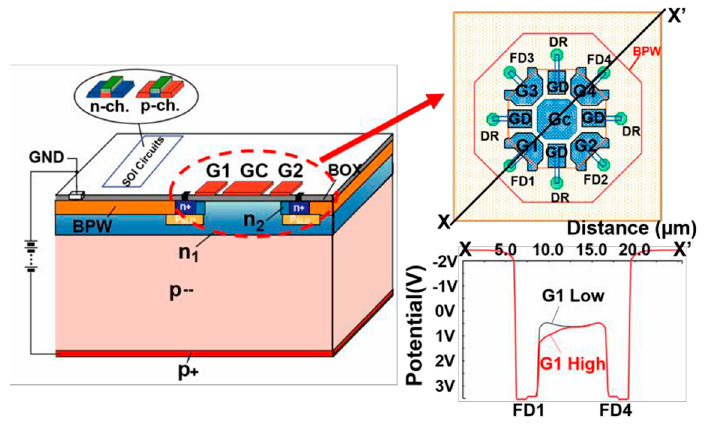
Figure 1. Structure of the SOI-based pixel detector and equivalent 4-tap lock-in pixel layout with potential